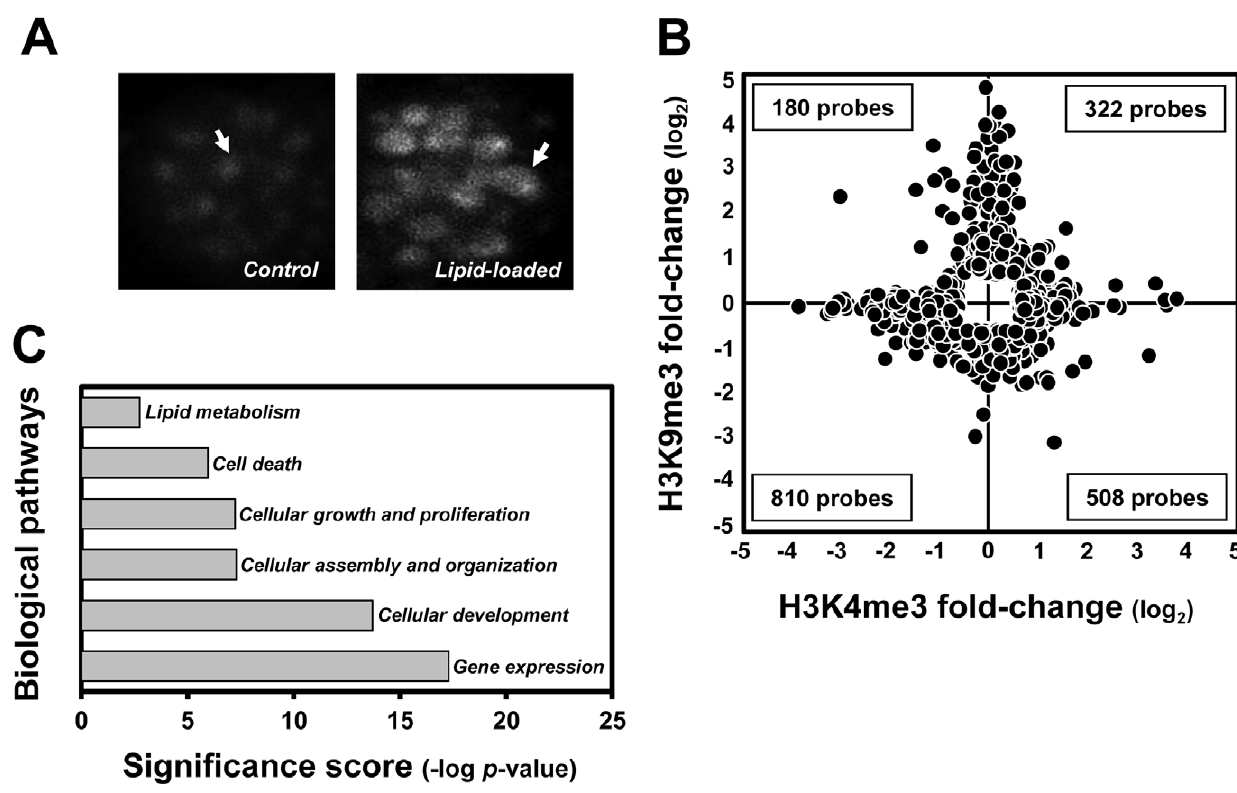
Figure 2. Genome-wide H3K9me3 and H3K4me3 variations in lipid-accumulated mouse primary hepatocytes determined by ChIP- on-chip analysis. (A) BODIPY-labeled lipid droplets in non- and palmitate plus oleate-treated mouse primary hepatocytes. (B) Expression pattern of H3K9me3 and H3K4me3 targets (fold change $ 1.5 in at least one histone trimethylation status, p , 0.05, n=2 for each histone status, H3K9me3 and H3K4me3) in lipid-accumulated hepatocytes. (C) Biological pathways affected by H3K9me3 and H3K4me3 targets in response to lipid accumulation in hepatocytes ( p , 0.05).